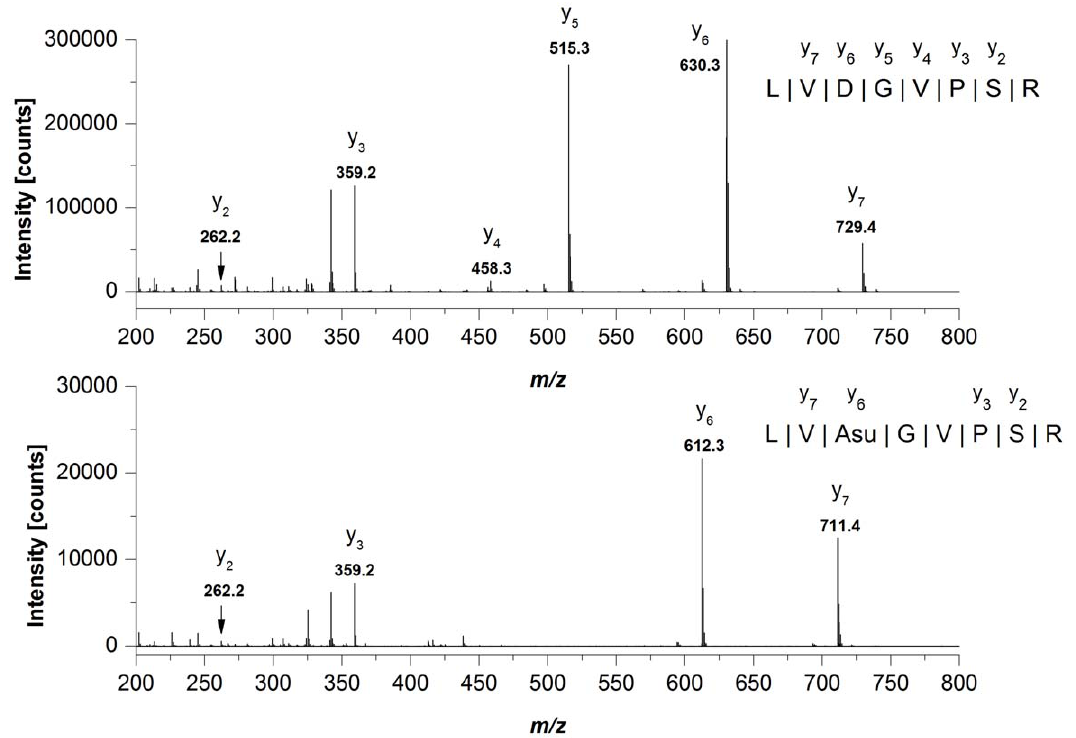
Figure 8. Low-energy CID mass spectra and resulting amino acid sequence of the doubly protonated Mab1 light chain peptide containing Asp-56 (upper panel) and Asu-56 (lower panel) at m/z 421.7 and 412.7.